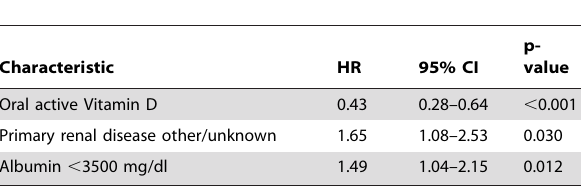
Table 3. Multivariate analysis of risk factors for peritonitis.